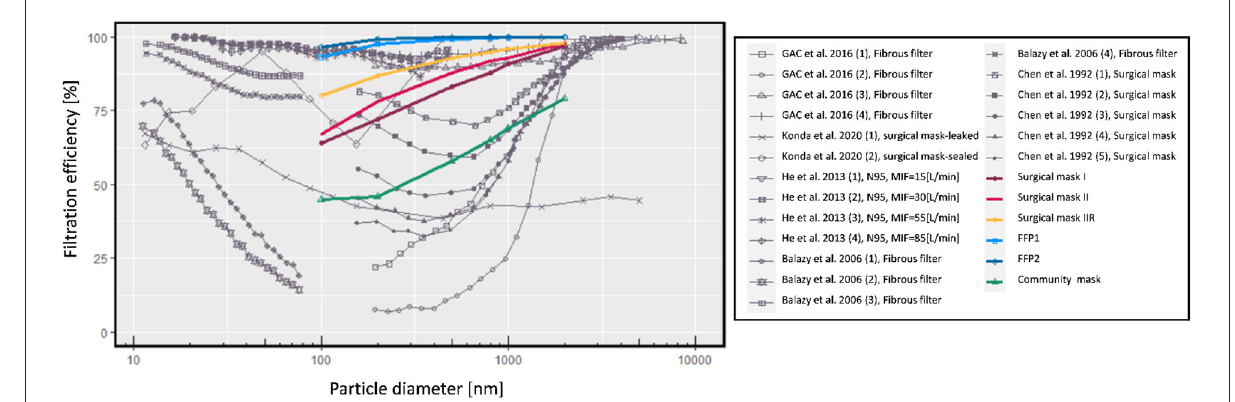
FIGURE1 Measured filtration efficiency at different particle sizes (46–50). The colored lines represent the filtration efficiencies of different types of masks that are being implemented in this